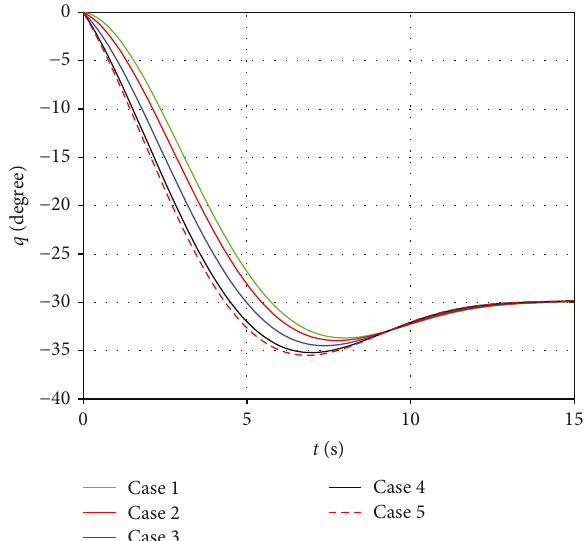
Figure 21: Intercept angle variation of Defender 2.